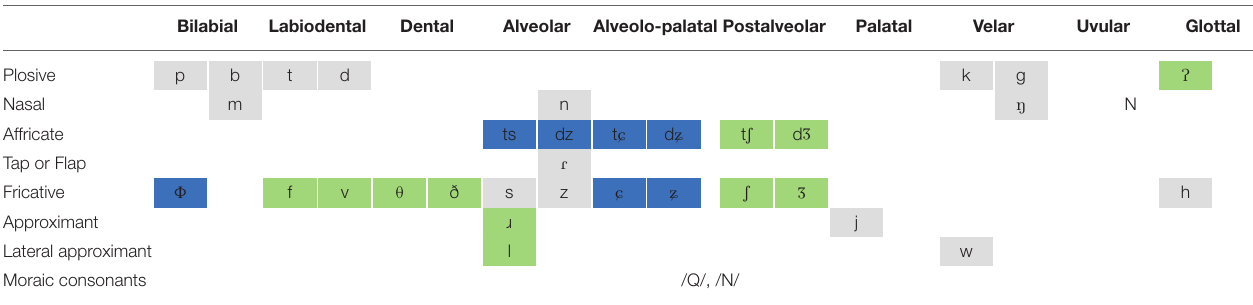
Approximant Lateral approximant Moraic consonants /Q/, /N/ Consonants shared by both inventories are marked in